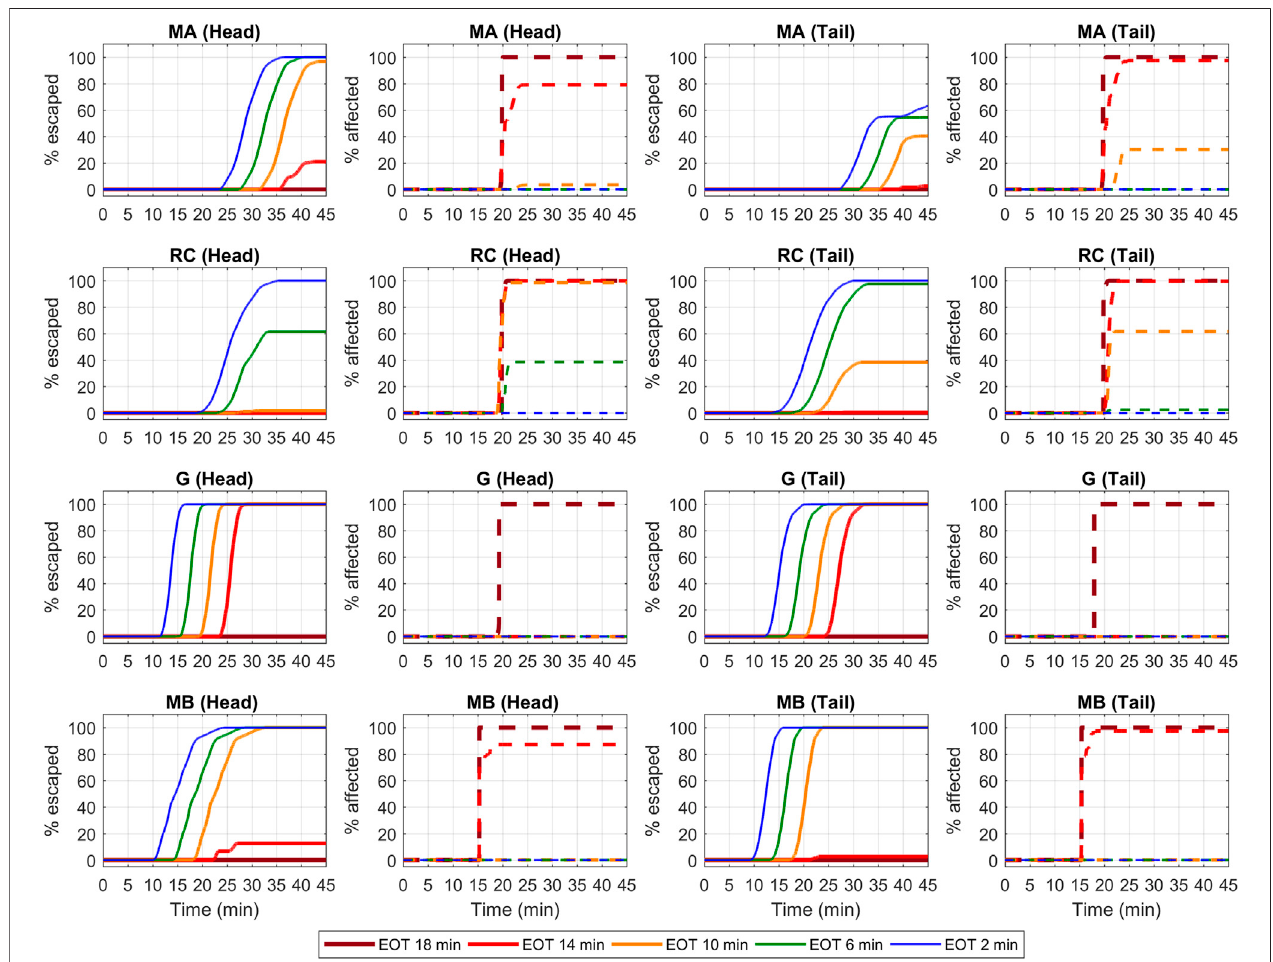
FIGURE 5 | Evacuation curves of the four examined schools (EOT (cid:1) 2, 6, 10, 14, and 18 min.